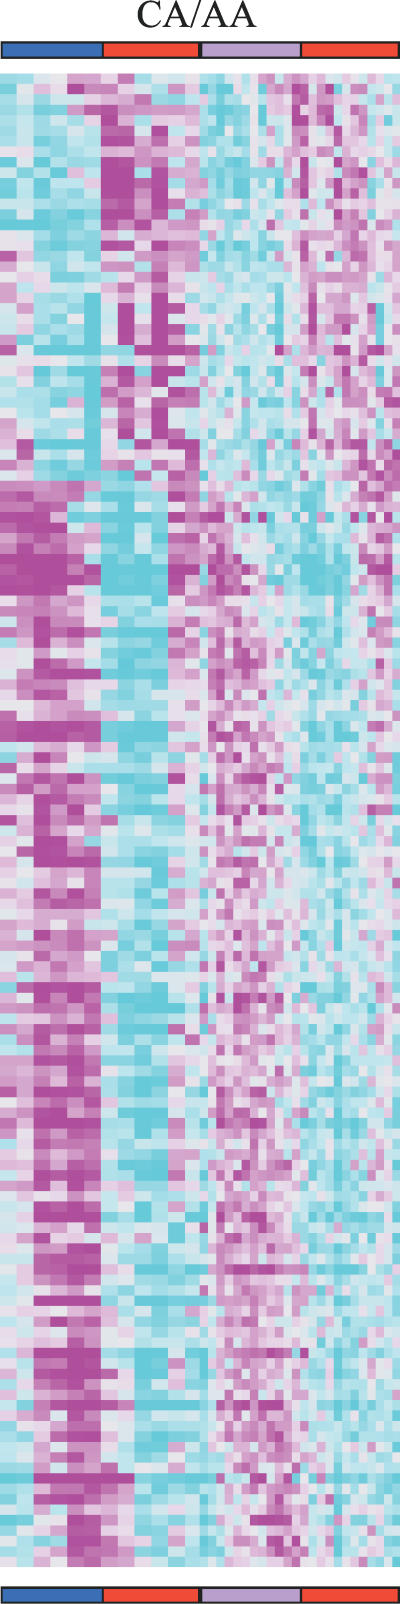
Phases of the Clock-Dependent TranscriptsThe transcripts from wild-type flies in CA/AA are shown by phase in the same format as Figure 3. Columns correspond to time points, and transcript profiles are represented by rows. Rows are ordered according to the estimated peak phase of the transcript profiles across the CA/AA data. Expression values represented by increasingly bright shades of magenta and cyan indicate, respectively, upregulation and downregulation relative to the experimental average (indicated by light gray). The red, blue, and violet bars above the phasegram indicate the warm, cold, and subjective cold phases, respectively.